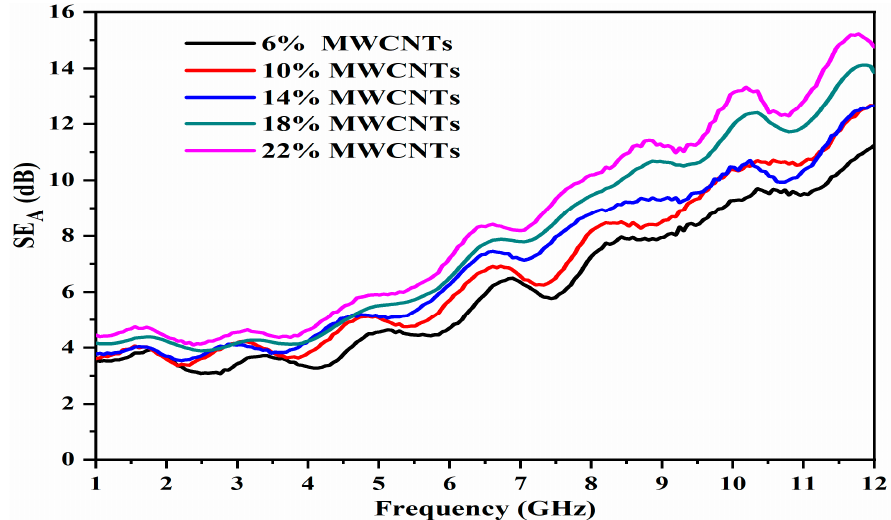
Table 2. Variation in absorption loss ( (cid:1845)(cid:1831) (cid:3002) ) for the OPEFB/PLA/MWCNTs composites. MWCNTs (wt.%)